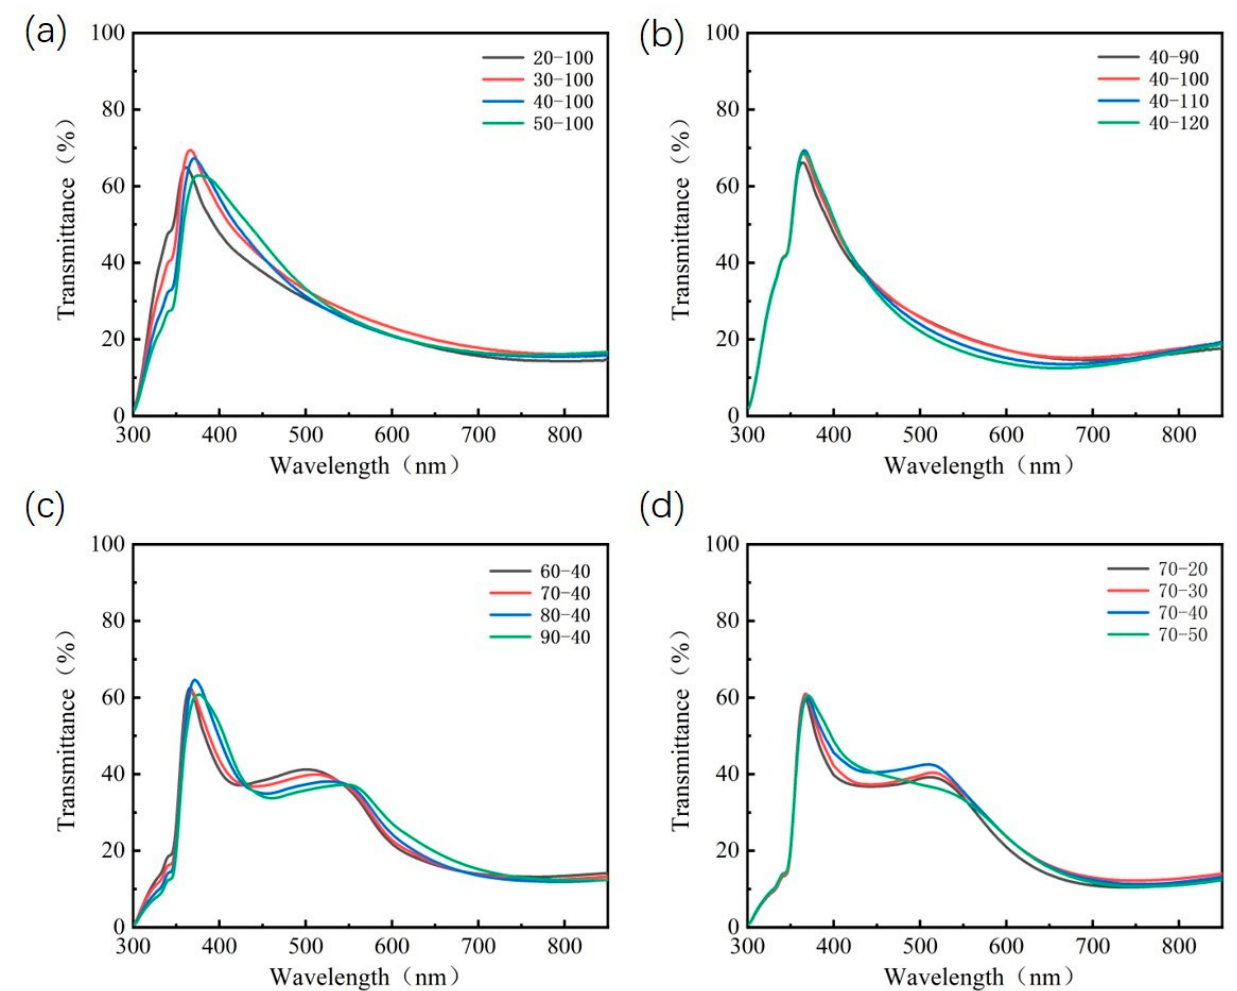
Figure 6. The experimental transmittance spectrum of ( a ) glass/ag (15 nm)/CBP (20–50 nm)/LiF (100 nm); ( b ) glass/ag (15 nm)/CBP (40 nm)/LiF (90–120 nm); ( c ) glass/ag (15 nm)/CBP (40 nm)/LiF (100 nm)/CBP (60–90 nm)/LiF (40 nm); ( d ) glass/ag (15 nm)/CBP (40 nm)/LiF (100 nm)/CBP (70 nm)/LiF (20–40 nm).